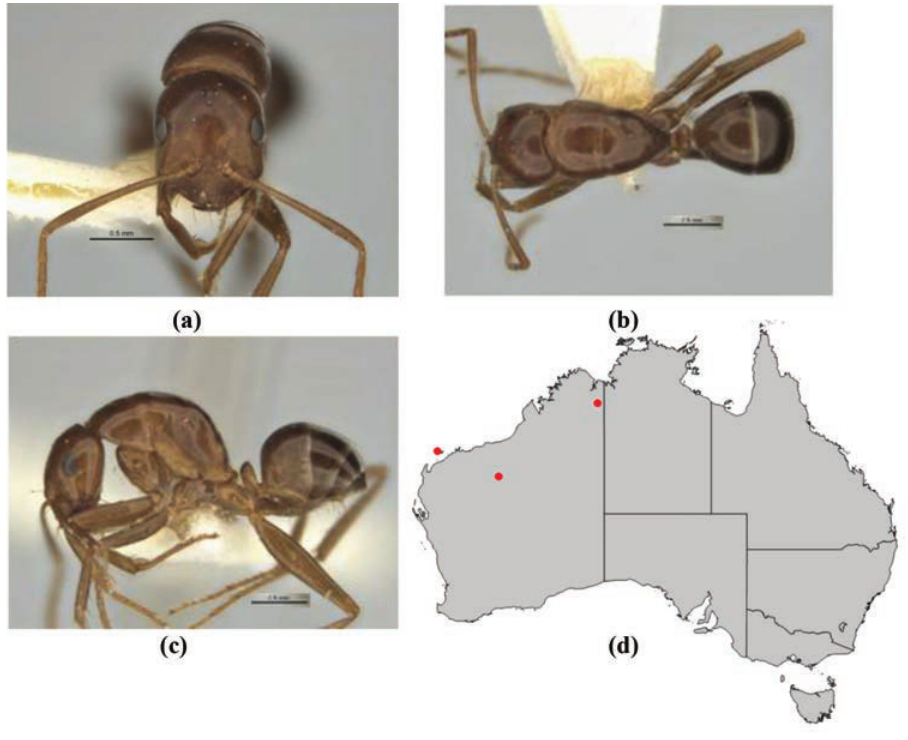
Figure 22. Melophorus teretinotus sp. n.: minor worker holotype (JDM32-004552) frons ( a ), profile ( b ) and dorsum ( c ); distribution map for the species ( d ). Low resolution scale bars: 0.5 mm ( a–c ). frons shining with superficial shagreenation or microreticulation only; frons consisting exclusively or almost exclusively of well-spaced, appressed setae only (small, erect setae, if present, usually confined to ocular triangle or posterior margin of head). Eye mod- erate (eye length 0.20–0.49 length of side of head capsule); in full-face view, eyes set above midpoint of head capsule; in profile, eye set anteriad of midline of head capsule; eyes elliptical or slightly reniform. In full-face view, frontal carinae concave; frontal lobes curved inward in front of antennal insertion. Anteromedial clypeal margin nar- rowly convex and protruding, clypeal midpoint distinctly notched; clypeal psammo- phore set at or just above anterior clypeal margin; palp formula 6,4. Five mandibu- lar teeth in minor worker; mandibles triangular, weakly incurved; third mandibular tooth distinctly shorter than apical tooth and teeth numbers two and four; masticatory margin of mandibles approximately vertical or weakly oblique. Mesosoma . Integu- ment of pronotum, mesonotum and mesopleuron moderately shining and shagreenate throughout; anterior mesosoma in profile broadly convex; erect pronotal setae absent; in profile, metanotal groove absent; propodeum shining and uniformly striolate; pro- podeum always smoothly rounded; propodeal dorsum and declivity confluent; erect propodeal setae always absent; appressed propodeal setulae short, separated by